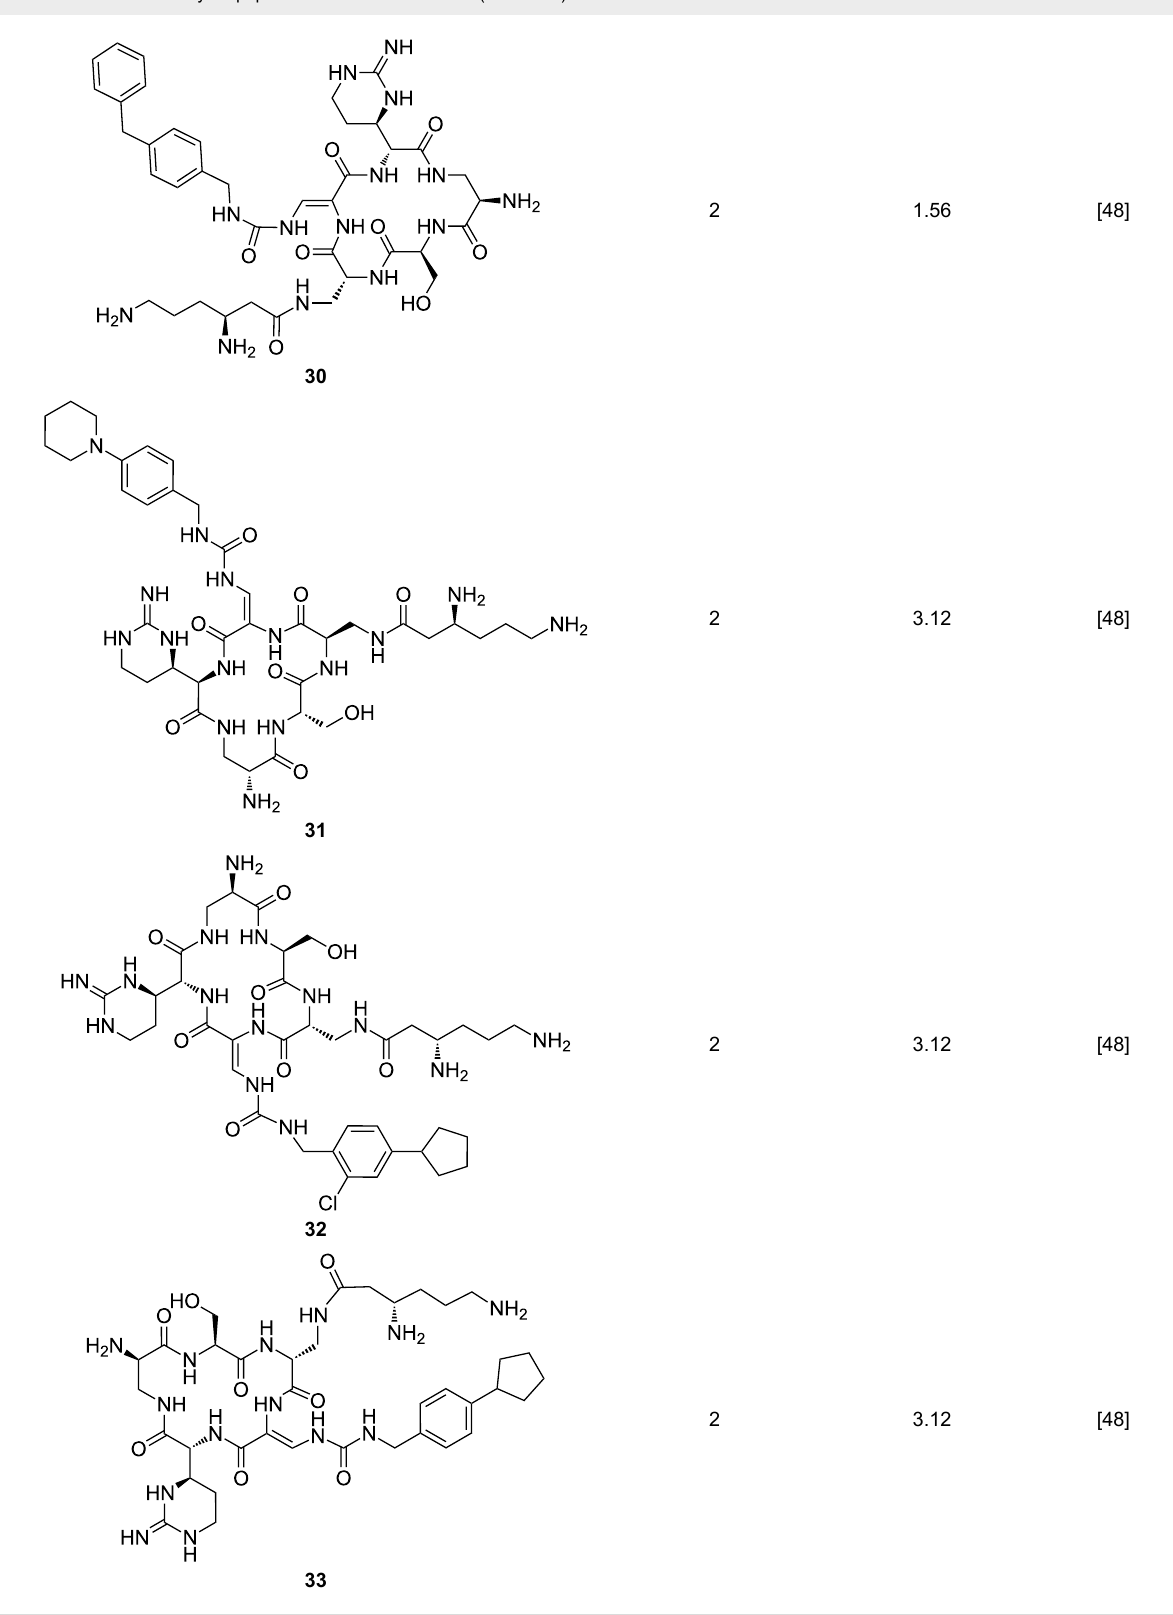
Table 1: Structures of cyclic peptides with their MIC values.